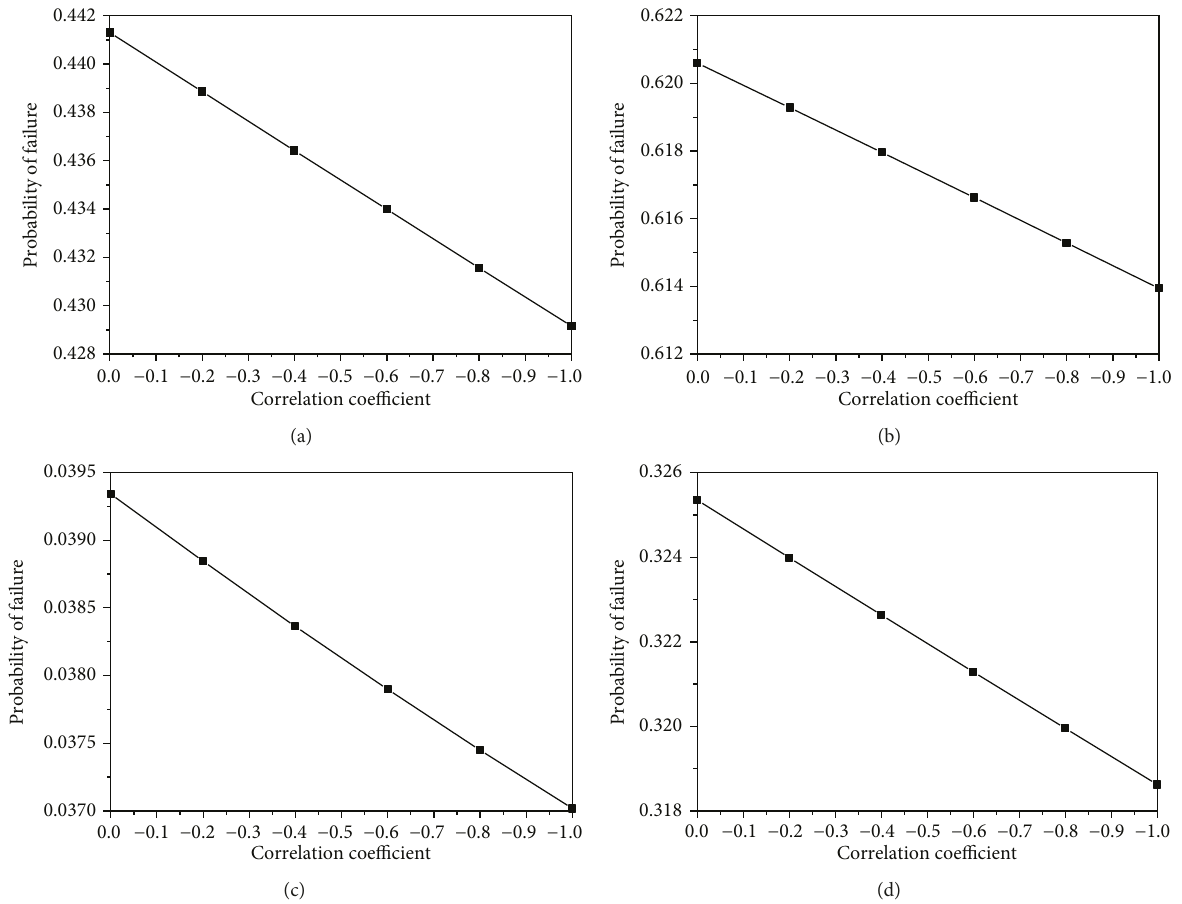
Figure 12: E ff ect of parameter correlation on slope failure probability at the following observation points (at 48 hours): (a) observation point at the middle in the loam slope; (b) observation point at the toe in the loam slope; (c) observation point at the middle in the silt slope; (d) observation point at the toe in the silt